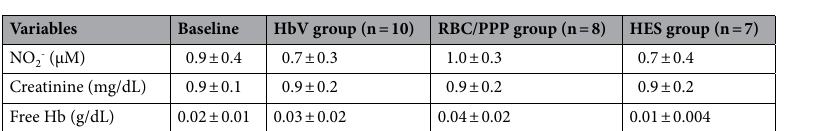
Controlling coagulopathy should be further investigated using other blood substitutes with haemostatic capac- ity, including PLT substitutes 39 , or the combined resuscitation fluids of crystalloids, colloids, or albumin. Lastly,